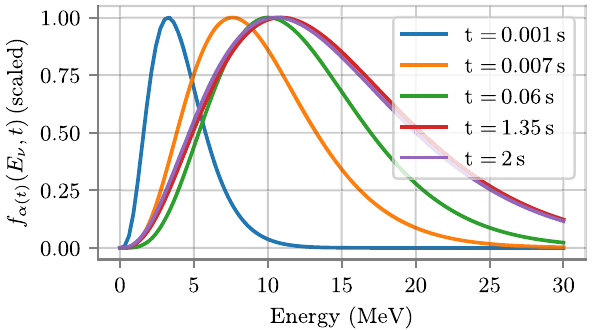
Fig. 3 ¯ ν e energy spectrum of a CCSN with a 27 . 0M (cid:2) progenitor mass at different times during the